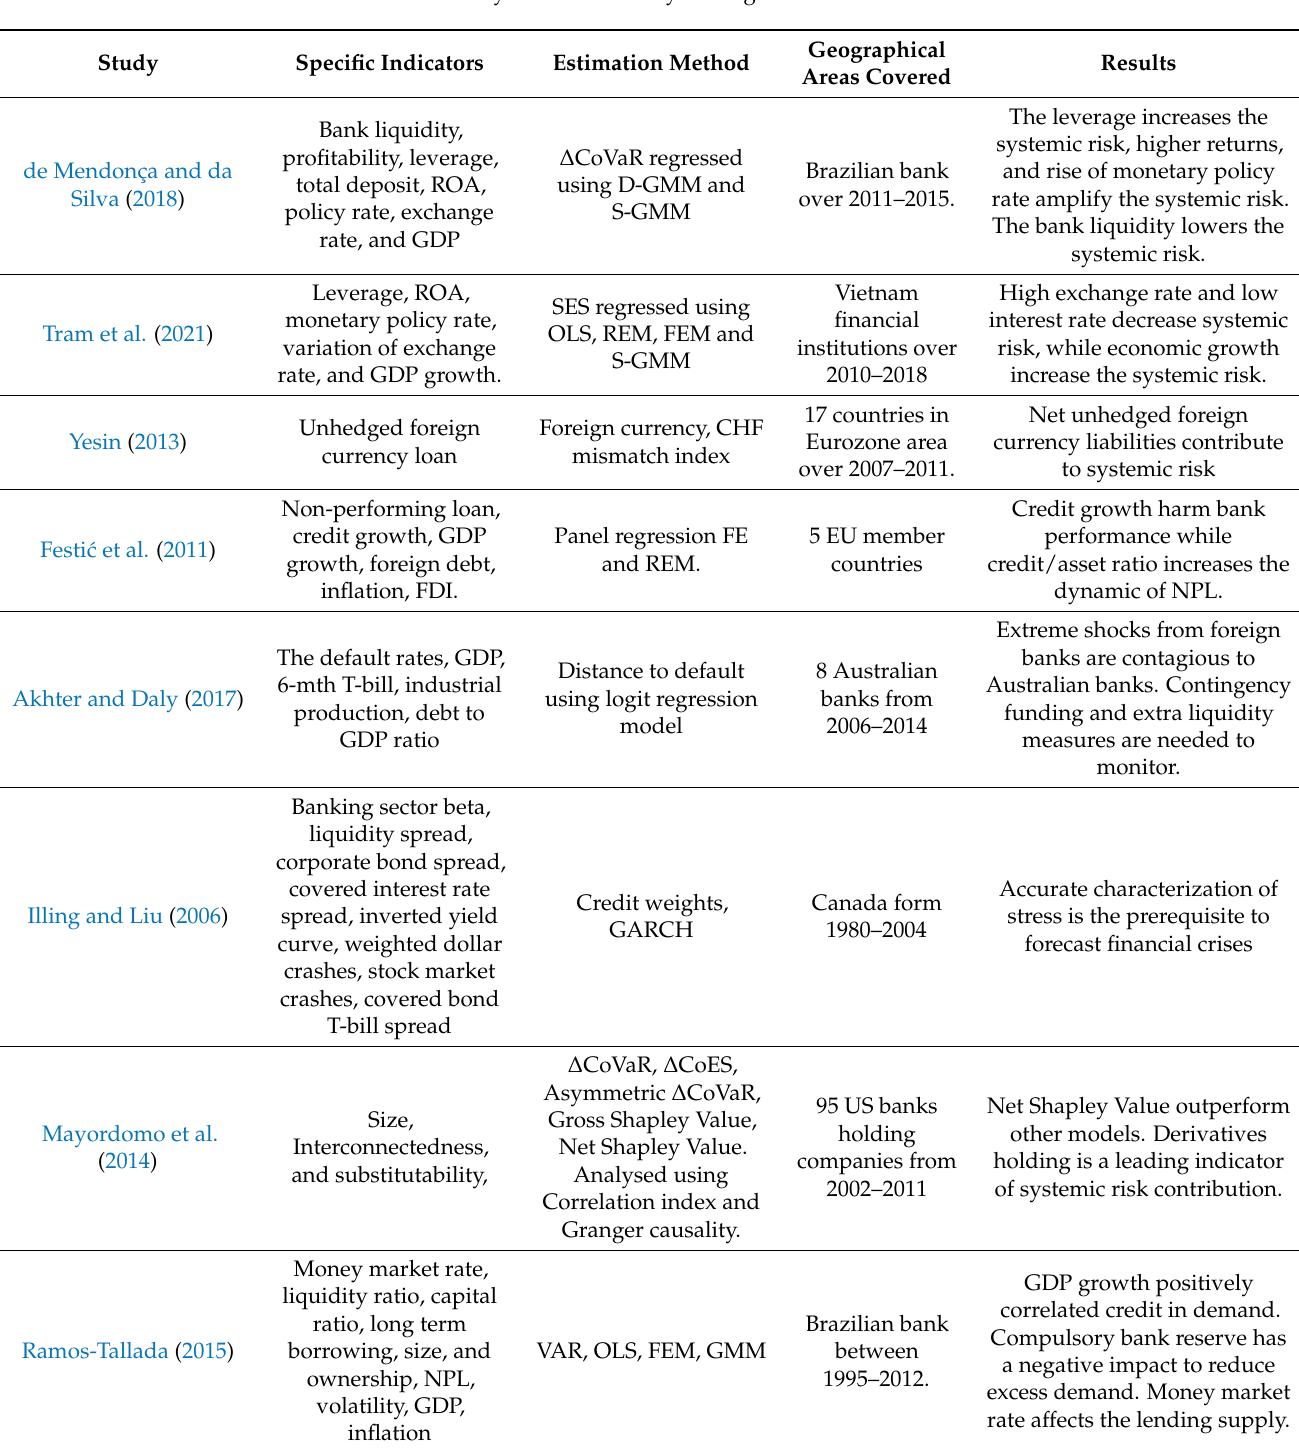
Table 1. Summary of selected study